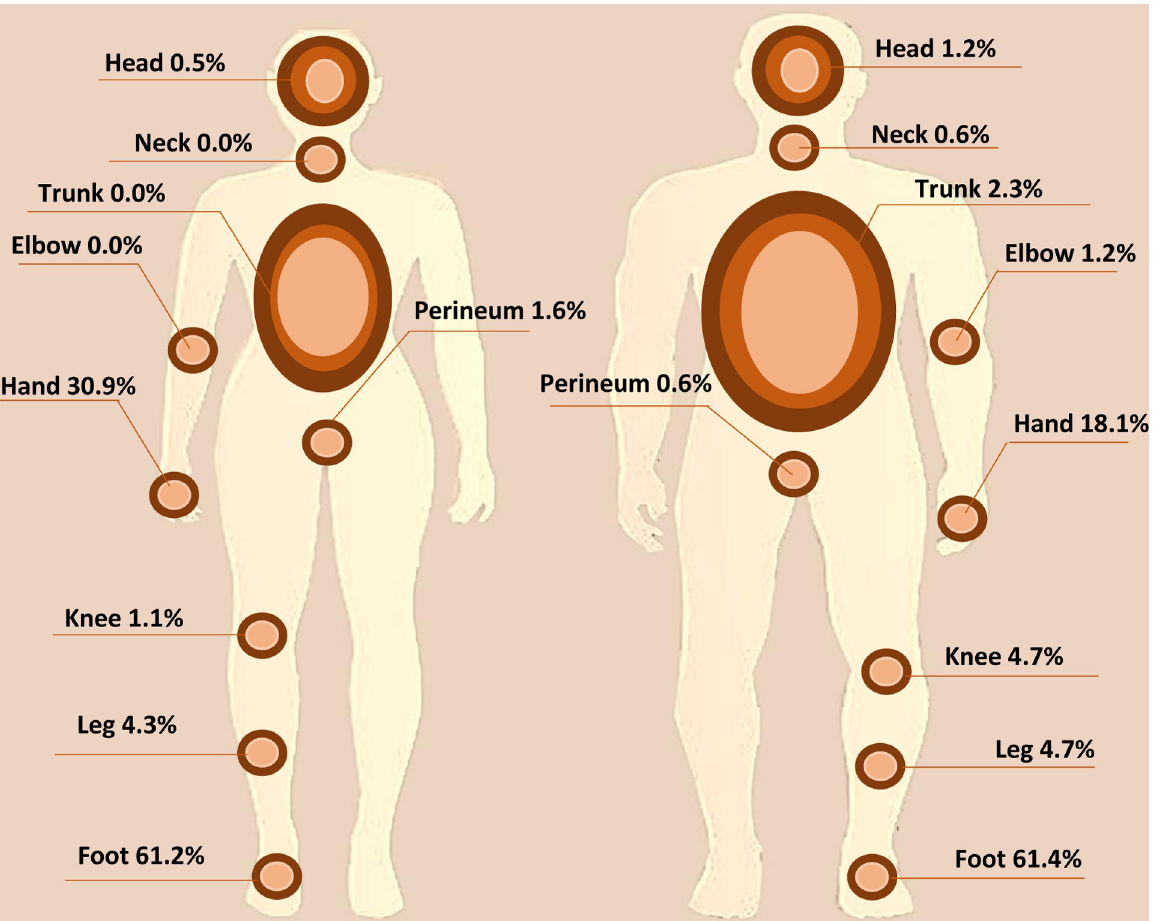
Fig 3. Physical distribution of mycetoma lesions for female (left side) and male (right side) cases. The feet constituted more than 60% of the sites of the lesion in both males and females. The fewest lesions were recorded on the neck and perineum for males and on the neck, trunk, and